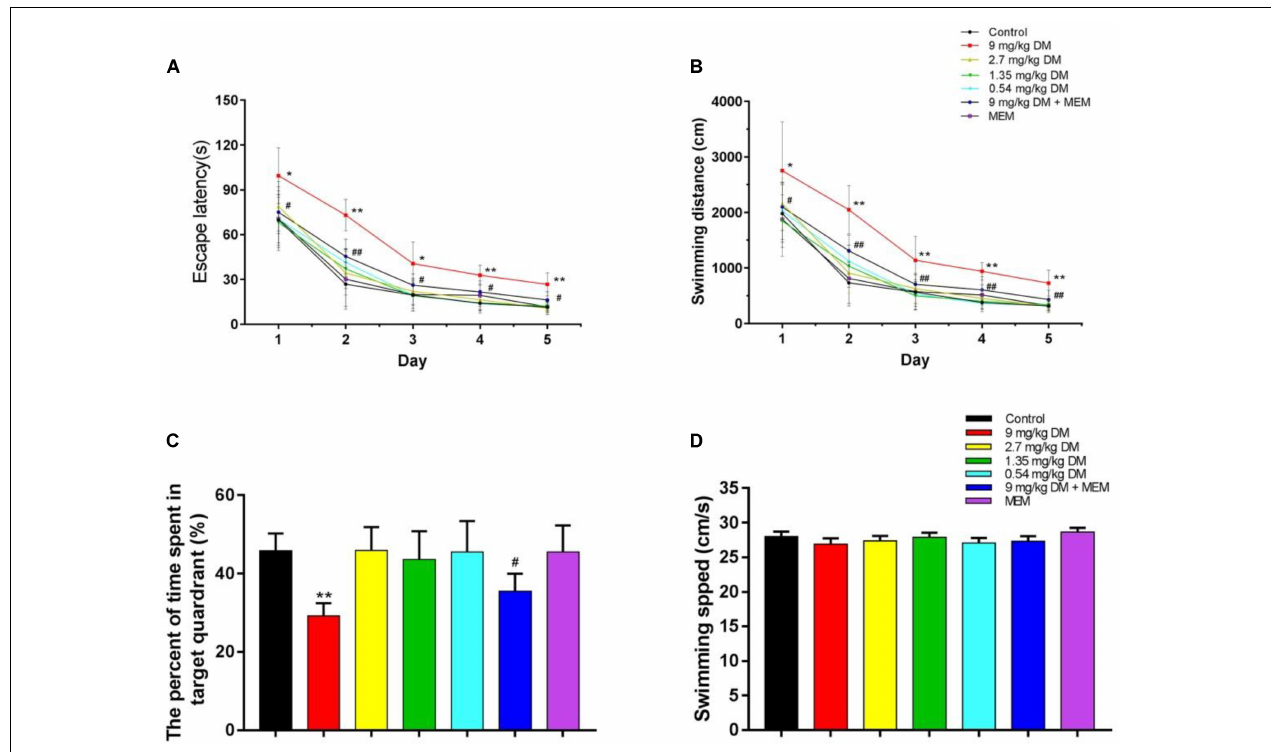
FIGURE 1 | The evaluation of learning and memory ability in MWM test. The results of MWM test are shown: (A) escape latency, (B) swimming distance, (C) the percent of time spent in target quadrant, and (D) swimming speed. The group treated with the highest dose of deltamethrin (9 mg/kg) demonstrated significant learning and memory impairment compared with the control group, while the other deltamethrin treated groups (2.7, 1.35, and 0.54 mg/kg) did not. And the co-administrated of deltamethrin and memantine group ameliorated the cognitive impairment observed in the 9 mg/kg treated group. No significant differences in swimming speed were found between these groups. ∗ P < 0.05 compared to the control group. ∗∗ P < 0.01 compared to the control group. ## P < 0.01 compared to the 9 mg/kg DM group. # P < 0.05 compared to the 9 mg/kg DM group. n = 12 in each group. DM: deltamethrin, MEM: memantine.